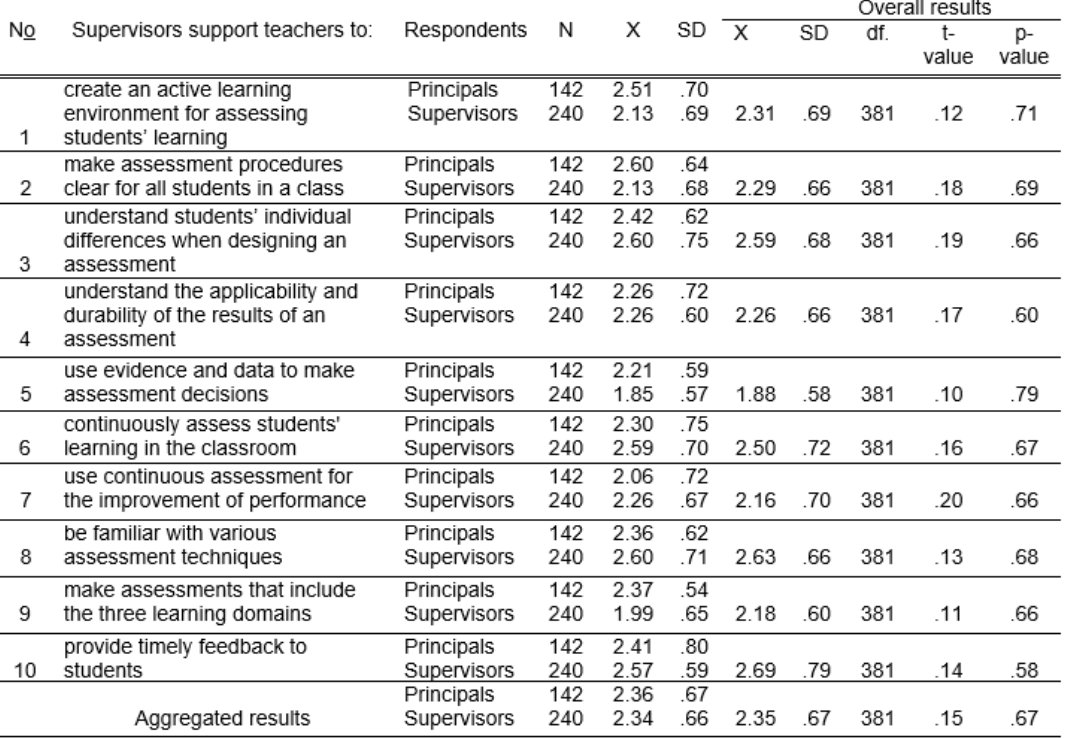
Table 2. Respondents’ views on supervisory support to teachers within the dimension